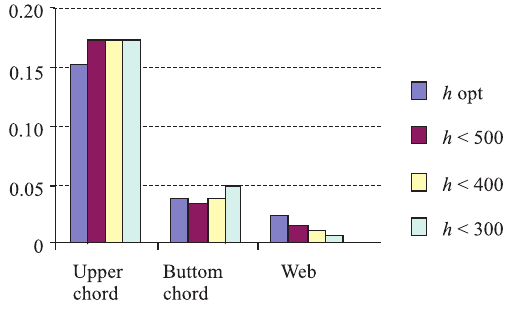
Fig. 14. Steel expenditures in m 3 for chords and webs with reference to the second load